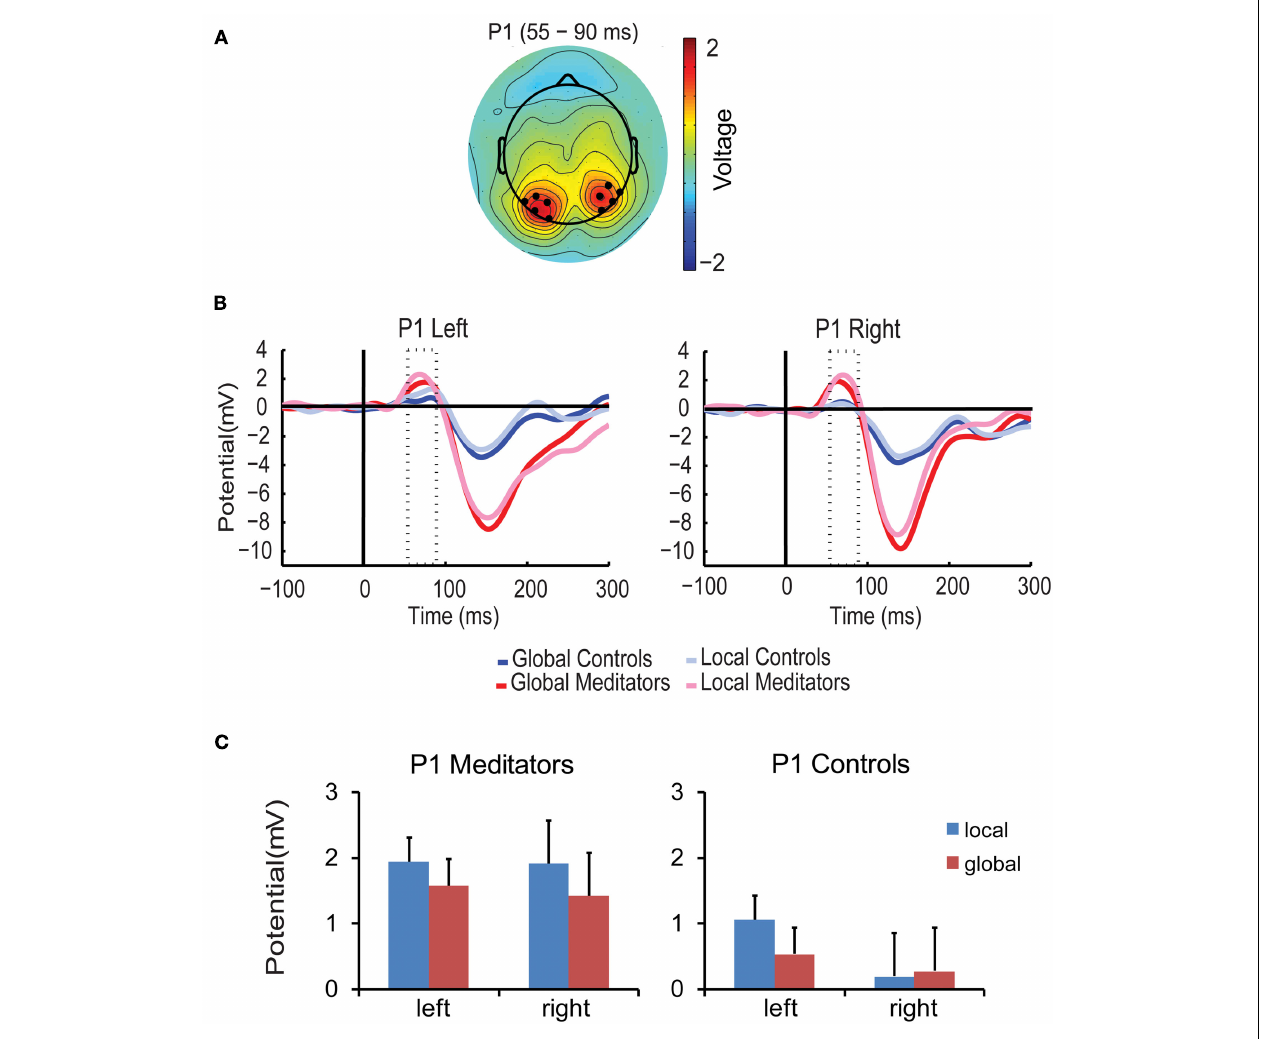
Controls in blue. Dark colored ERPs correspond to global targets, light colored ERPs correspond to local targets. (C) Bar plots show amplitude responses for each group (meditators/controls), target level (global/local) and hemisphere (left/right) averaged over the corresponding time period and electrodes. Error bars represent the